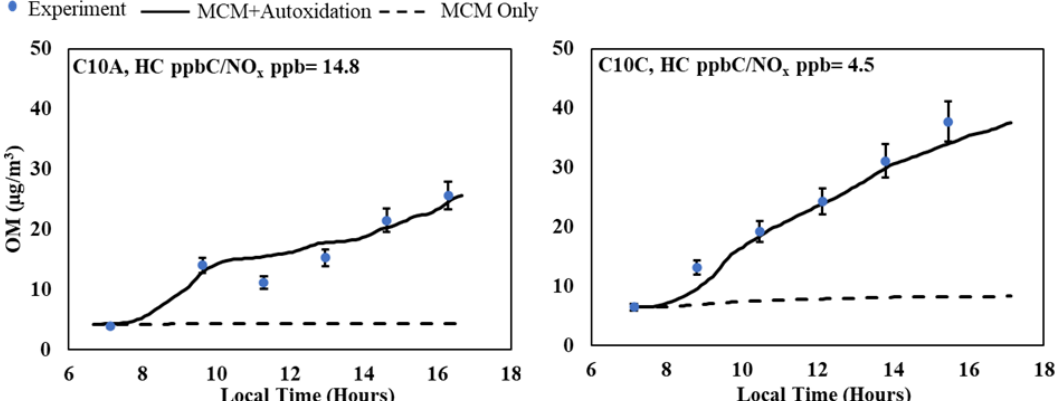
Figure 2. Comparison of SOA mass produced between simulations using a product distribution for C10 derived from the MCM (dashed line) and one from the MCM with alkyl peroxy radical autoxidation reactions added (solid line). The blue dots represent observed SOA data that are corrected for particle wall loss to the chamber. Error bars represent 9% uncertainty associated with the OC/EC and particle wall loss correction.